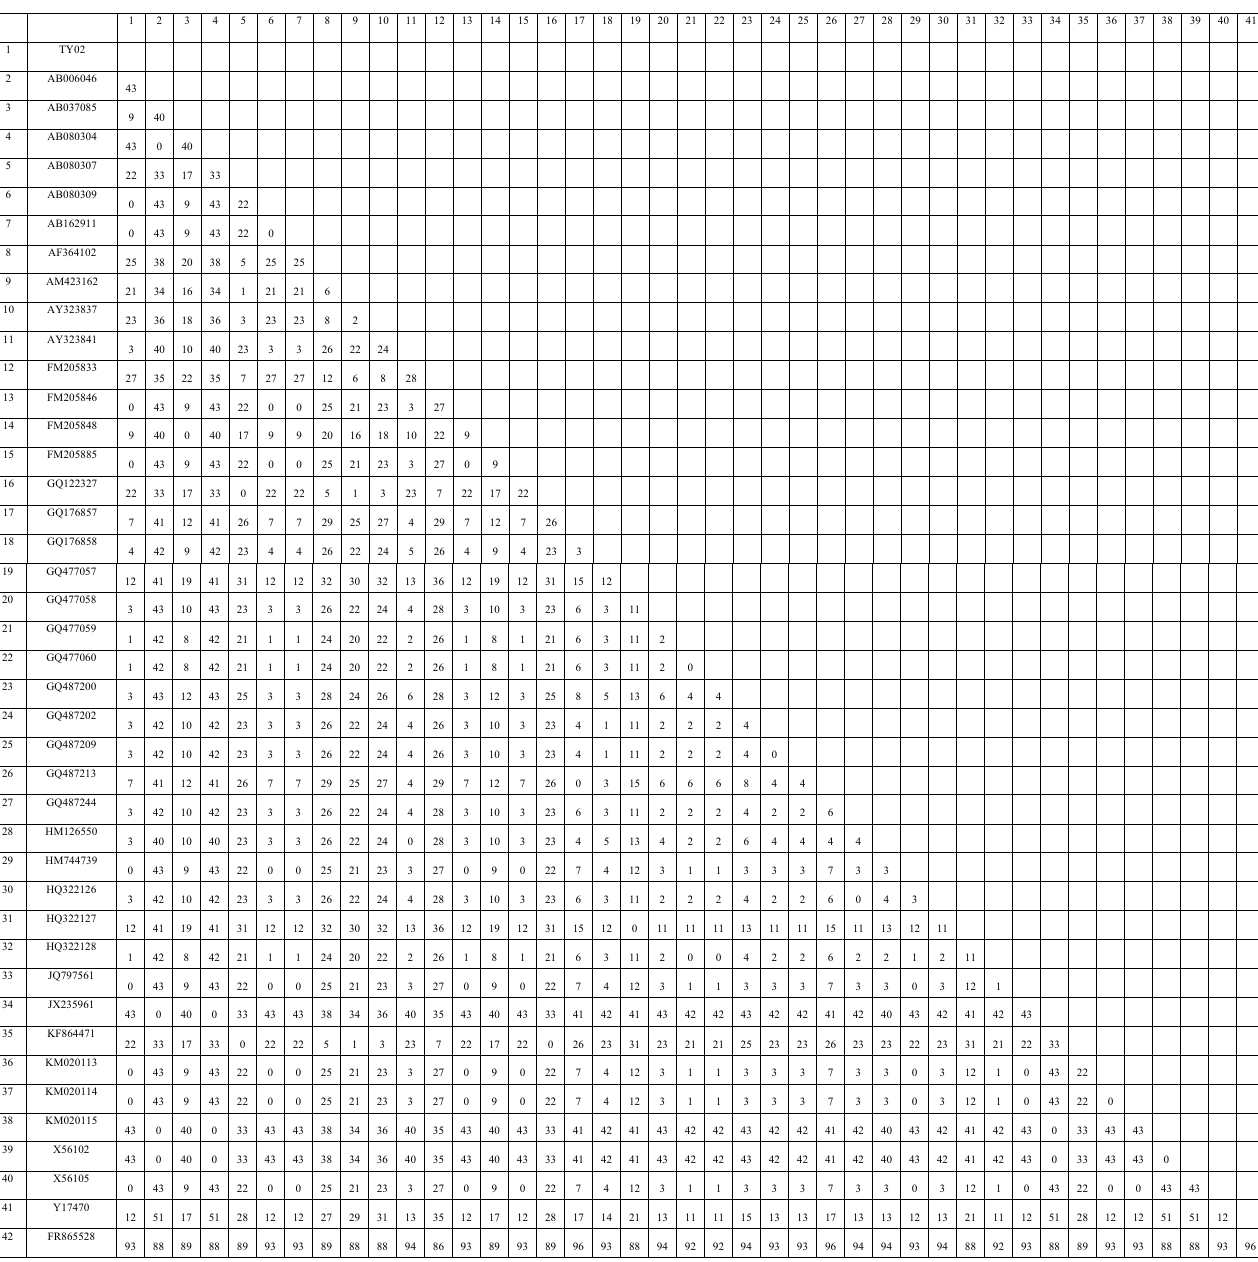
Tab. S2: Numbers of differences’ gene locus based on 18S rDNA sequences of